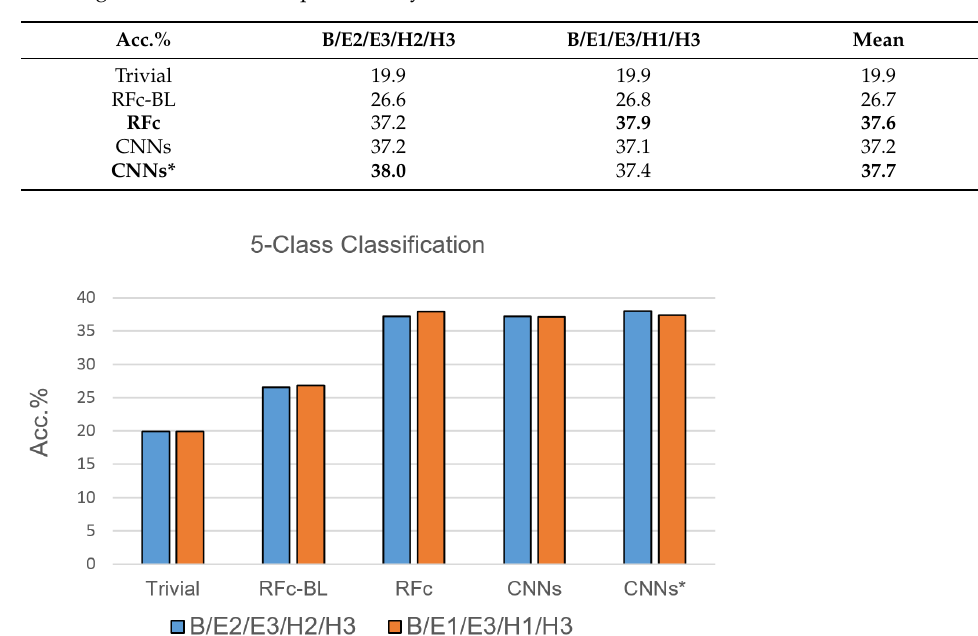
Table 4. Recognition approaches accuracy results of phasic stimuli 5-class classification task, the meaning of abbreviations is provided by the list in abbreviations section.